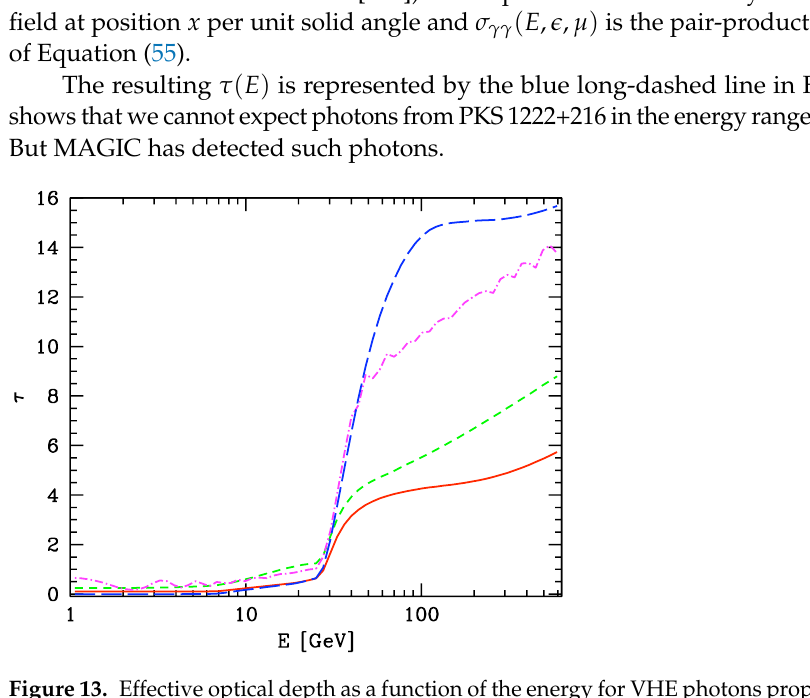
Figure 13. Effective optical depth as a function of the energy for VHE photons propagating in the BLR of PKS 1222+216. The blue long-dashed line corresponds to the process γγ → e + e − . The other three lines pertain to our model containing ALPs. Specifically, the violet dashed-dotted line corresponds to ( B = 2G, g a γγ = 0.25 · 10 − 11 GeV − 1 ) , the green short-dashed line to ( B = 0.4 G, g a γγ = 0.7 · 10 − 11 GeV − 1 ) and the red solid line to ( B = 0.2G, g a γγ = 1.4 · 10 − 11 GeV − 1 ) . (Credit